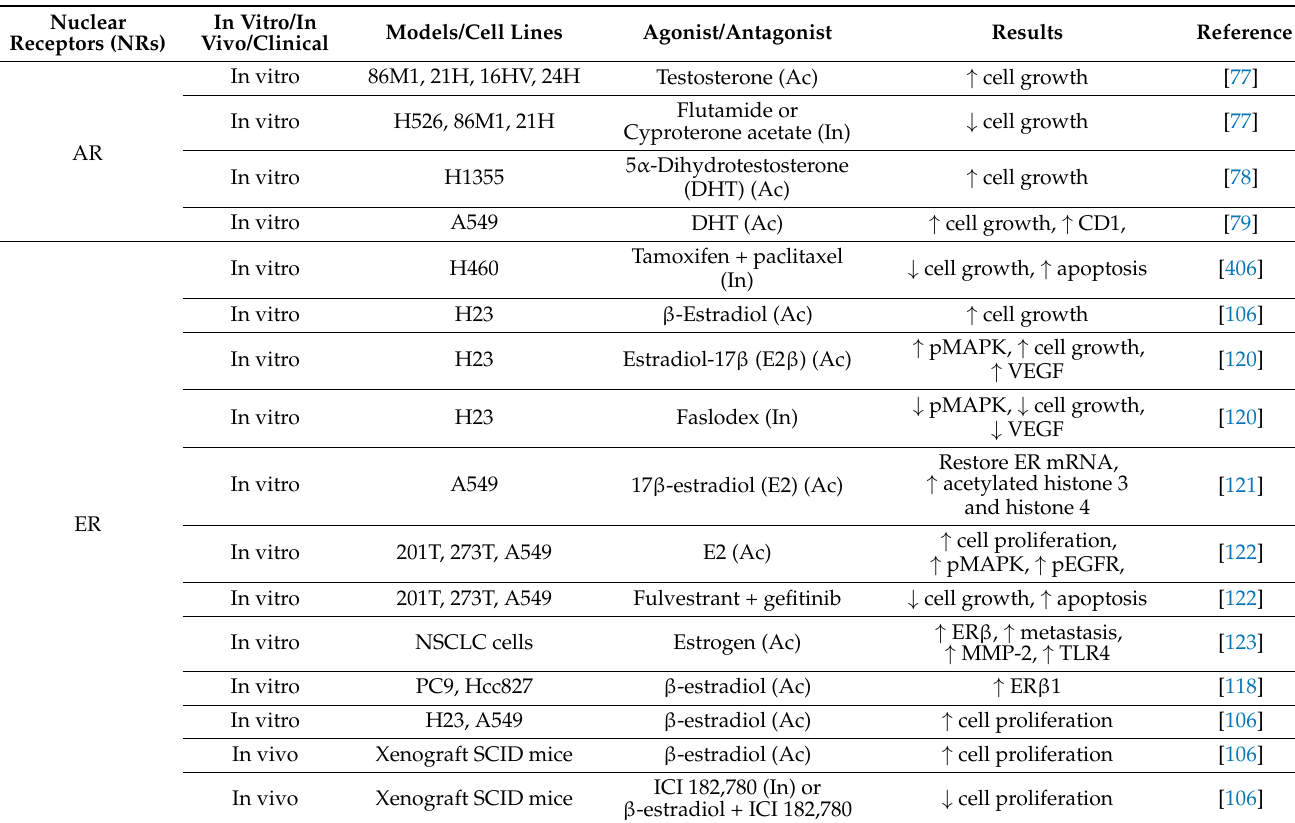
Table 2. Mechanistic role of various nuclear receptors in lung cancer in the presence of their